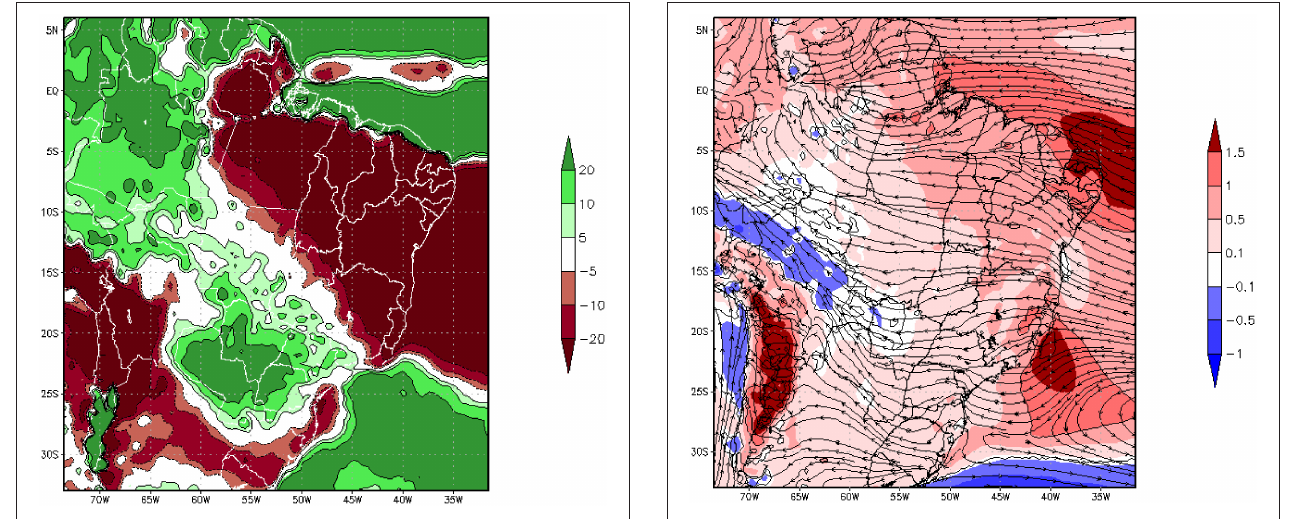
FIGURE 11 | Same as Figure 10 but for the wind changes (m/s) on the period 2041–2070.